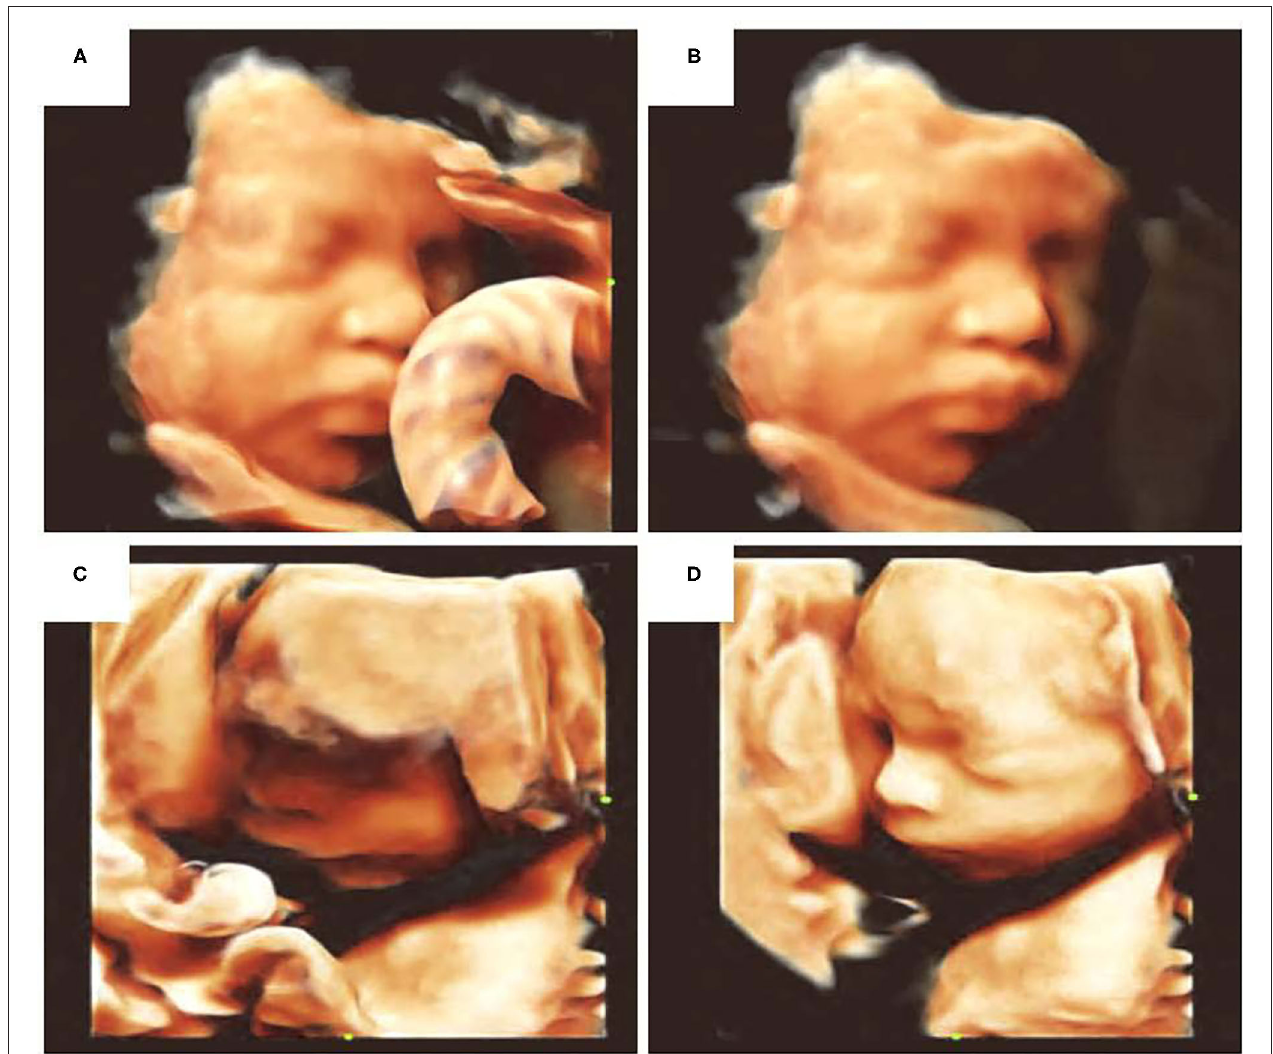
FIGURE 2 | Optimization of fetal facial 3D ultrasound imaging. (A) Facial occlusion with umbilical cord, (B) elimination of facial occlusion, (C) facial edge incomplete reconstruction, (D) facial imaging optimization. used to eliminate variations in fetal position, orientation, and size by taking the central areas of the head and eyes as feature points. Subsequently, craniofacial structures were automatically delineated using the segmentation method, and five craniofacial diameter lines (biparietal diameter, occipito-frontal diameter, interorbital diameter, bilateral orbital diameter, and orbital- calvaria diameter) were accurately measured to realize the intelligent diagnosis and evaluation of the fetal face